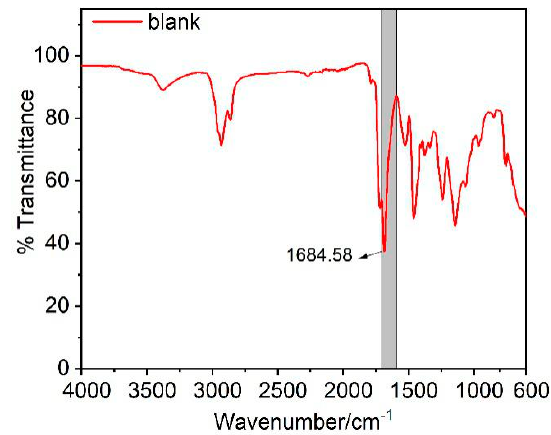
Figure 6. Integral area of the carbamate carbon’s characteristic peak of the blank sample.